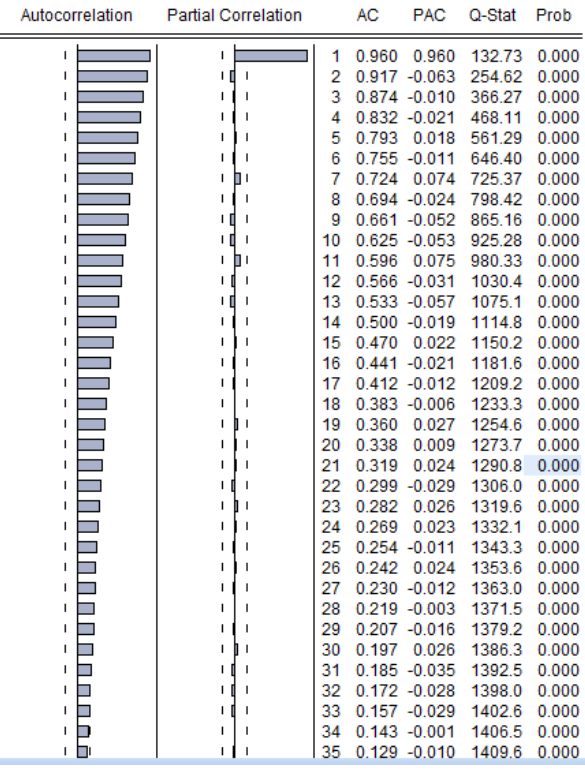
Figure 6. Сorrelogram of the State Debt of Ukraine 2004–2020 in first